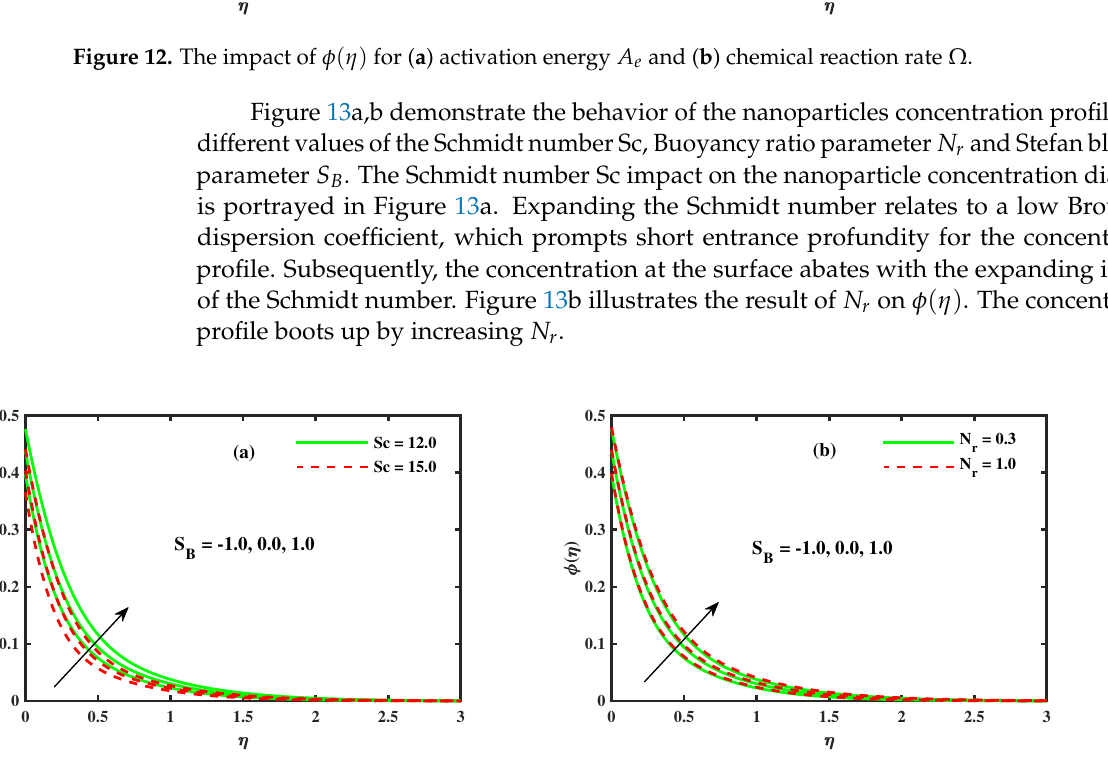
Figure 13. The impact of φ ( η ) for ( a ) Schmidth number Sc and ( b ) Buoyancy ratio parameter N r